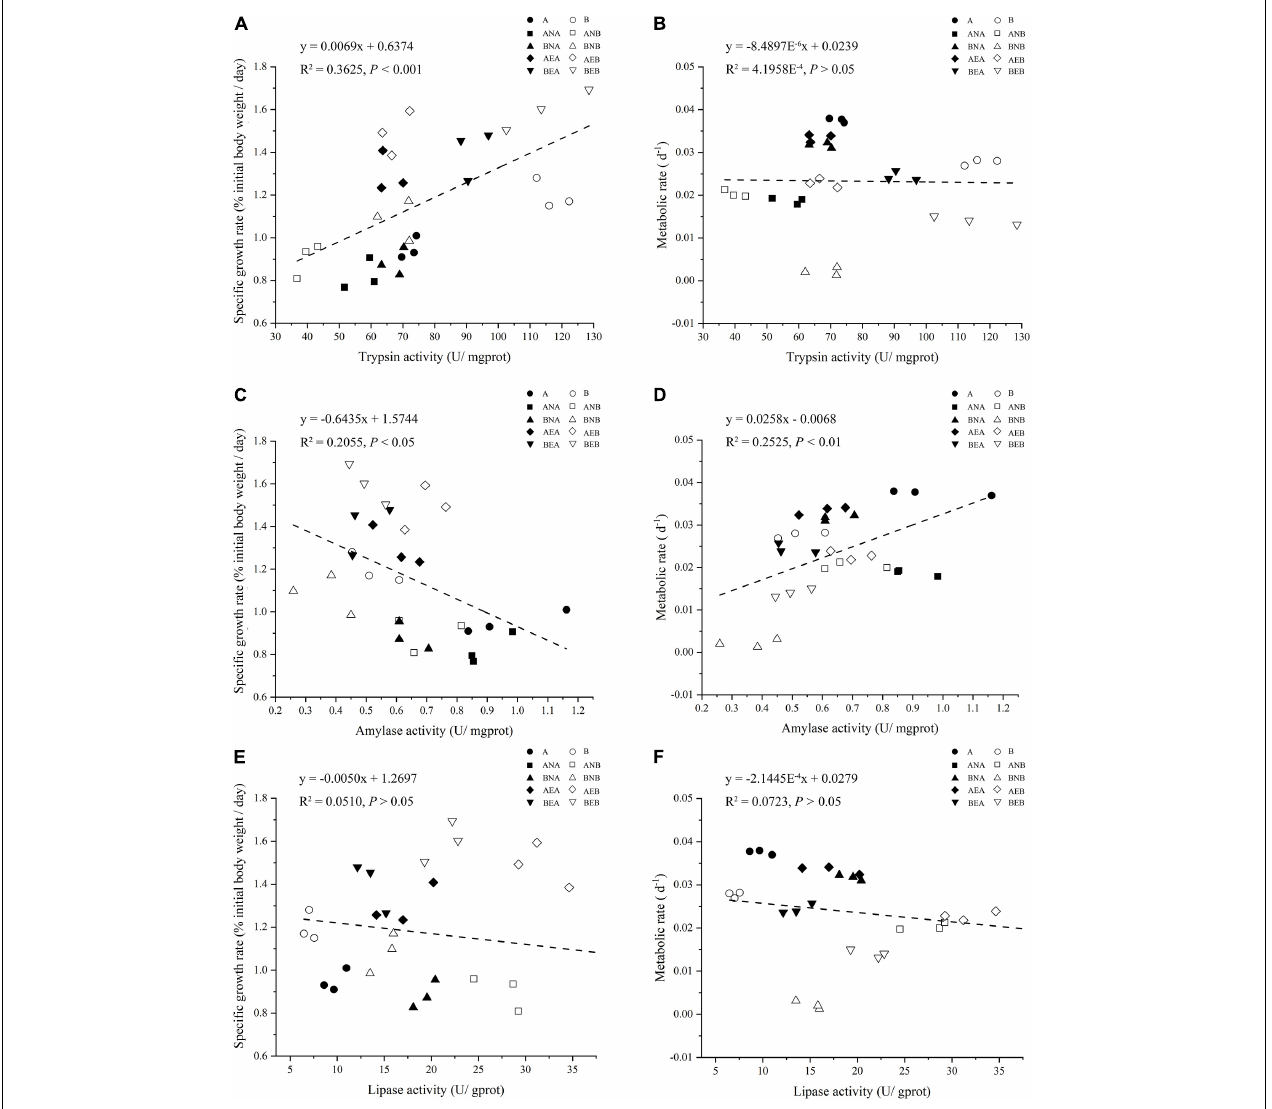
FIGURE 5 | Relationships between trypsin activities, specific growth rates, and metabolic rates of A. japonicus (A,B) ; Relationships between amylase activities, specific growth rates, and metabolic rates of A. japonicus (C,D) ; Relationships between lipase activities, specific growth rates, and metabolic rates of A. japonicus (E,F)